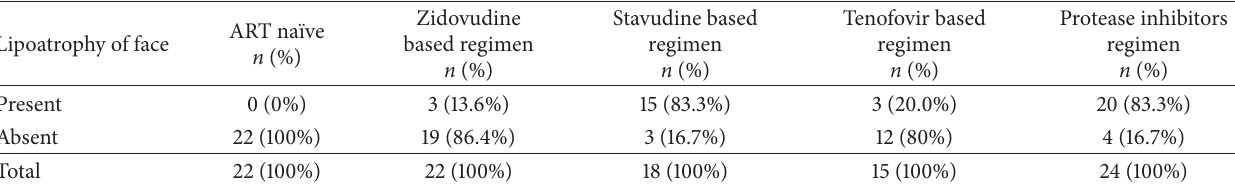
Table 2: Prevalence of lipoatrophy of face in different study